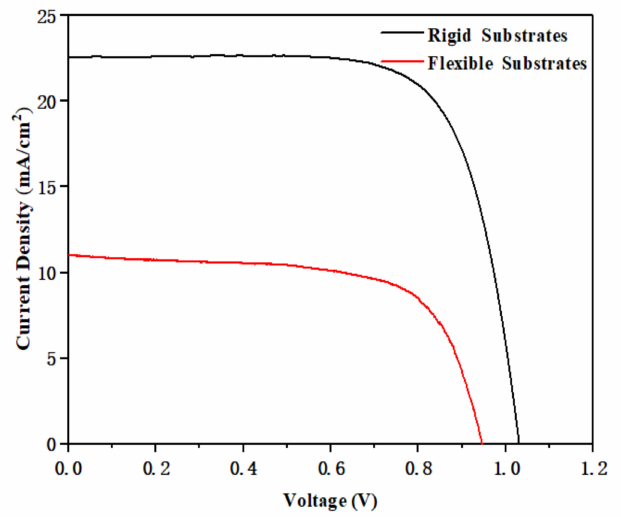
Figure 6. SEM image for perovskite layer deposited on flexible substrate.